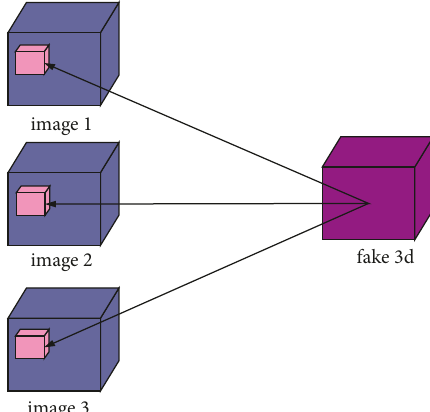
Figure 3: Fake 3D